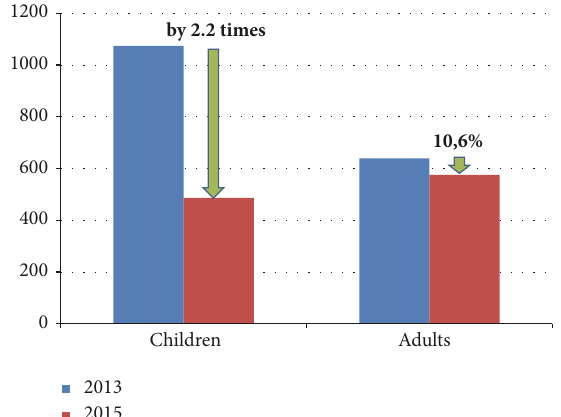
Figure 6: Comparative analysis of dynamics of morbidity of children’sand adult populations of the AmurRegion (data of the epidemiological monitoring, per 100 000